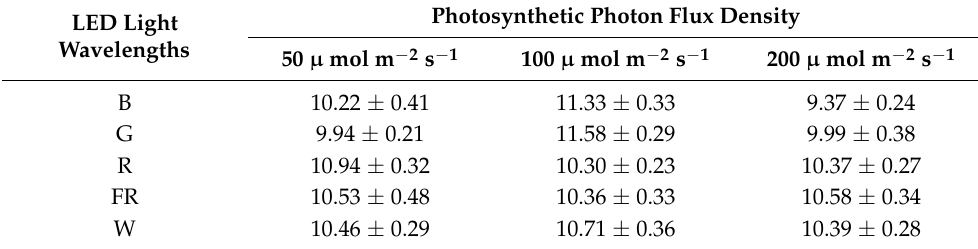
Table 2. The mycelial growth curve (AUMGC) of C. acutatum under different photosynthetic photon flux densities.